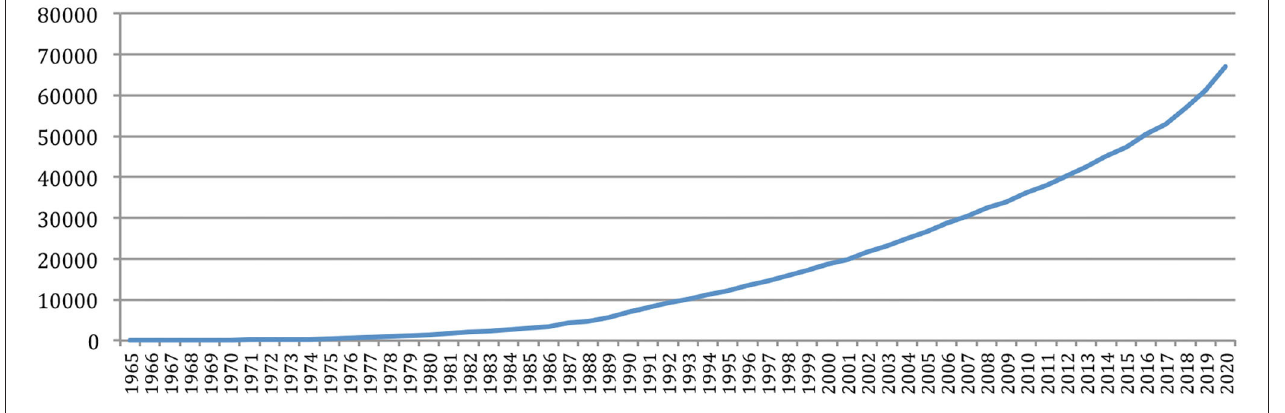
FIGURE 4 | Number of different authors over the years.